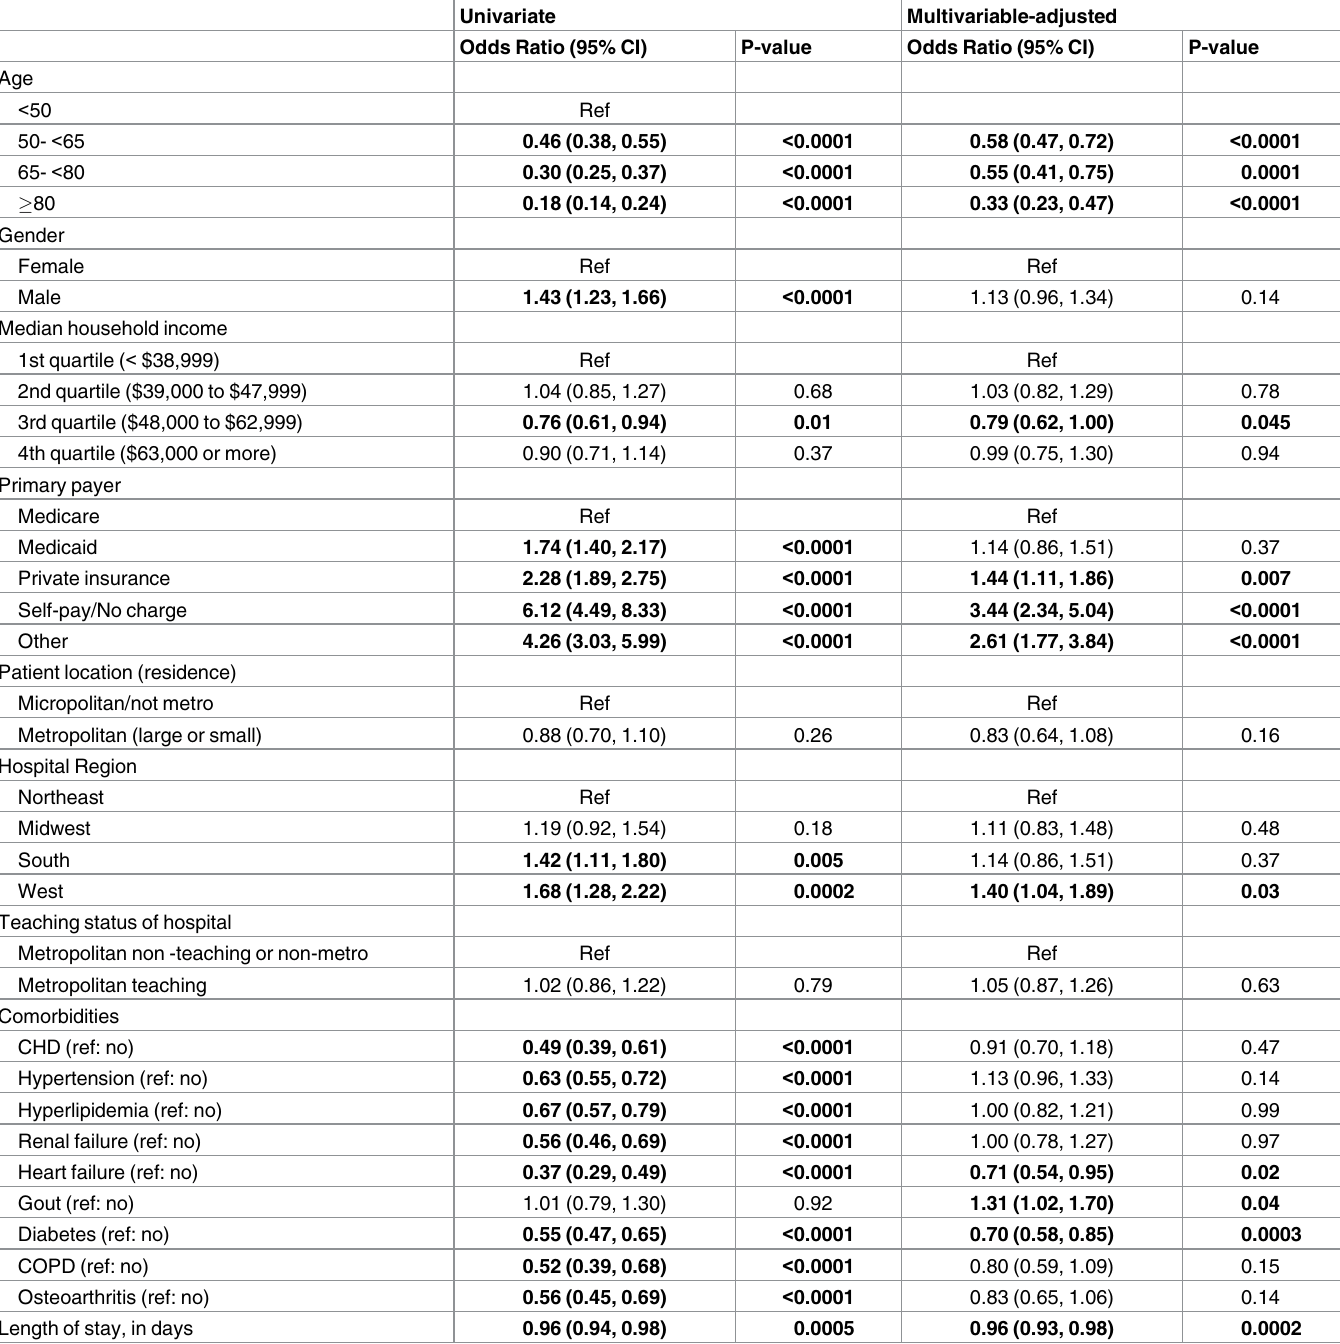
Table 6. Predictors of discharge to home among patients who had a hospital admission with septic arthritis after presenting to